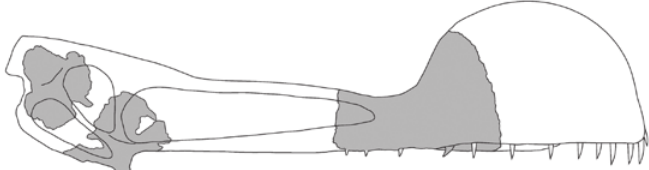
Fig 2 - Reconstruction of the skull of Tropeognathus cf. T. mesembrinus (MN 6594-V) with the preserved parts indicated in grey.